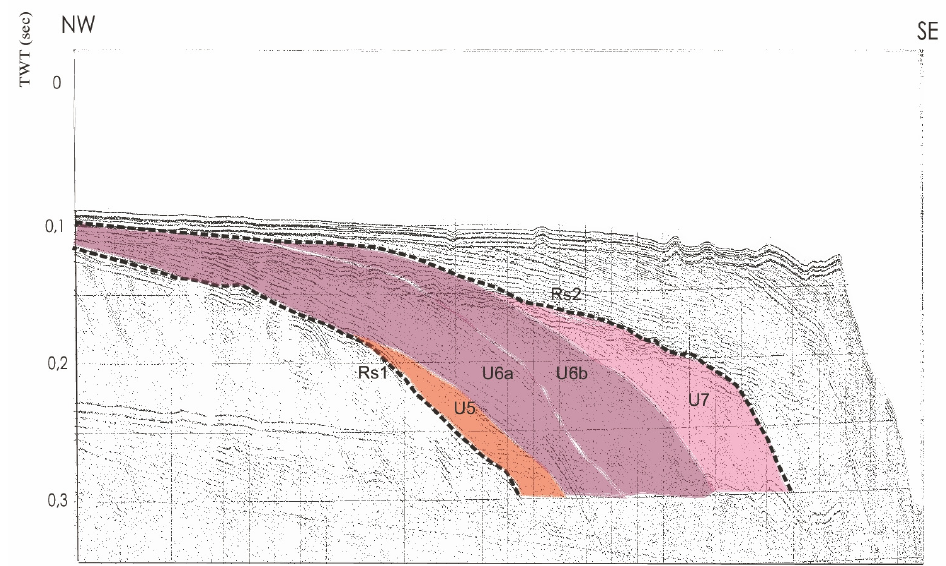
Figure 9. Line drawing of seismic profile showing the stratigraphic architecture of the 220 to 120 ky prograding wedge (W2). This is part of the same seismic profile shown in Figure 5. W2 is interpreted as a 4th-order incomplete depositional sequence controlled by short-term glacio-eustatic eccentricity cycles with duration of approximately 100 ky and composed of transgressive deposits onlapping the ravinement surface RS1 (U5), lowstand deposits organized into two main sub-units (U6a and U6b) and forced regression deposits (U7). The top of the wedge is truncated by the ravinement surface RS2.